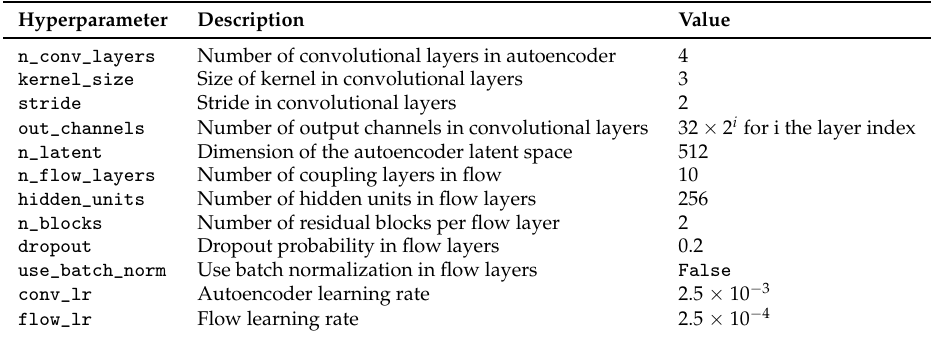
Table A1. Model and training hyperparameters, where the leftmost column lists the variable name, the middle column offers a brief description of the hyperparameter’s function and the rightmost column lists the value we used in our final model. Note that all autoencoder architecture hyperpa- rameters refer to the encoder-side only (as the decoder is unused after